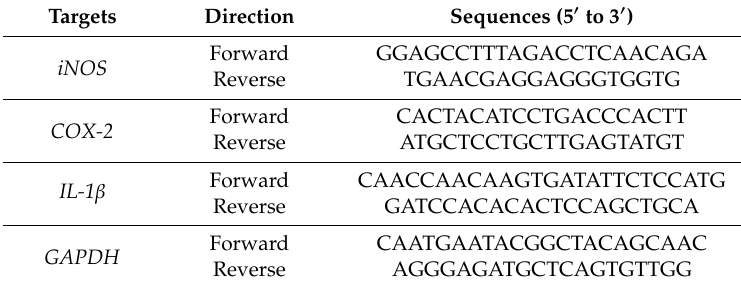
Table 3. Sequences of polymerase chain reaction (PCR) primers used in this